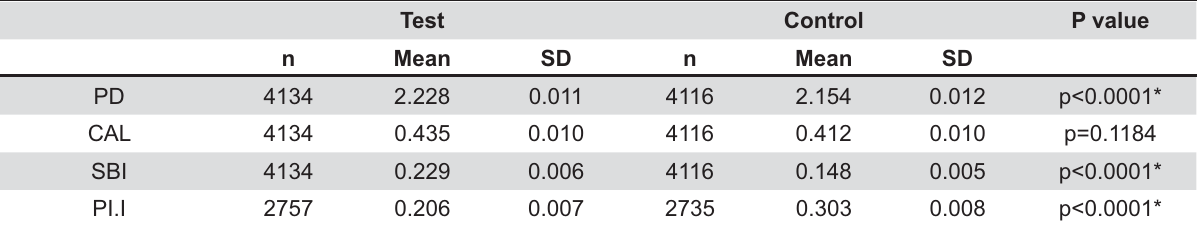
PD– probing depth (in millimeters); CAL– clinical attachment level (in millimeters); SBI– sulcus bleeding index (0- absence; 1- presence); Pl.I– plaque index (0- absence; 1- presence); n=number of sites evaluated; SD- standard